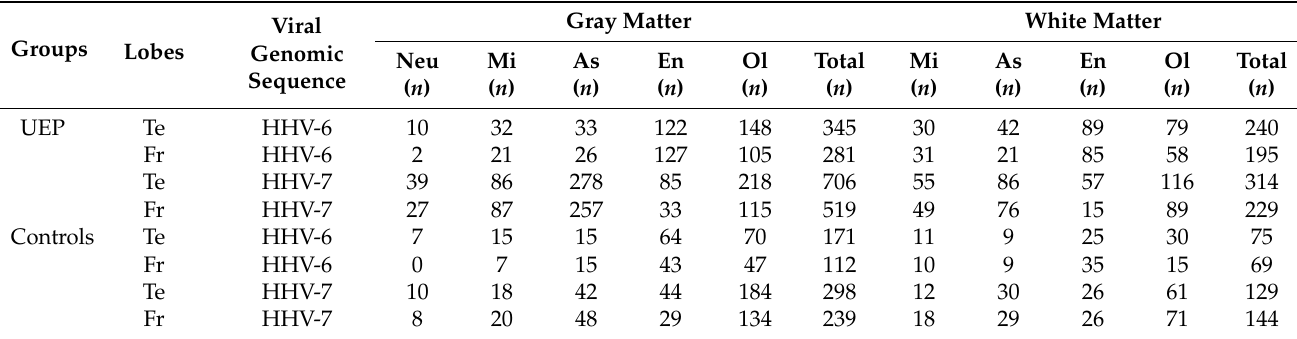
Table 2. Numbers of herpesvirus-6, -7 (HHV-6, -7) immunopositive cells in tissue samples of the frontal and temporal lobes in the UEP individuals and control group.